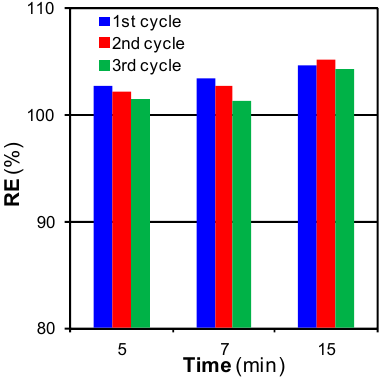
Figure 9. Effect of time and the number of adsorption–regeneration cycles on RE for supercritical water (SCW) regeneration at 300 bar and 425 °C with a SCW flow of 3 cm 3 ·min − 1 . Consequently, SCW regeneration could be described as a method slightly more efficient than SCCO 2 regeneration (RE SCW,300 bar,425 ◦ C,15 min = 104.6%; RE SCCO ◦ C,15 min = 100.3%), although 2 ,100 bar,400 it must be noted that SCW pressure was thrice SCCO 2